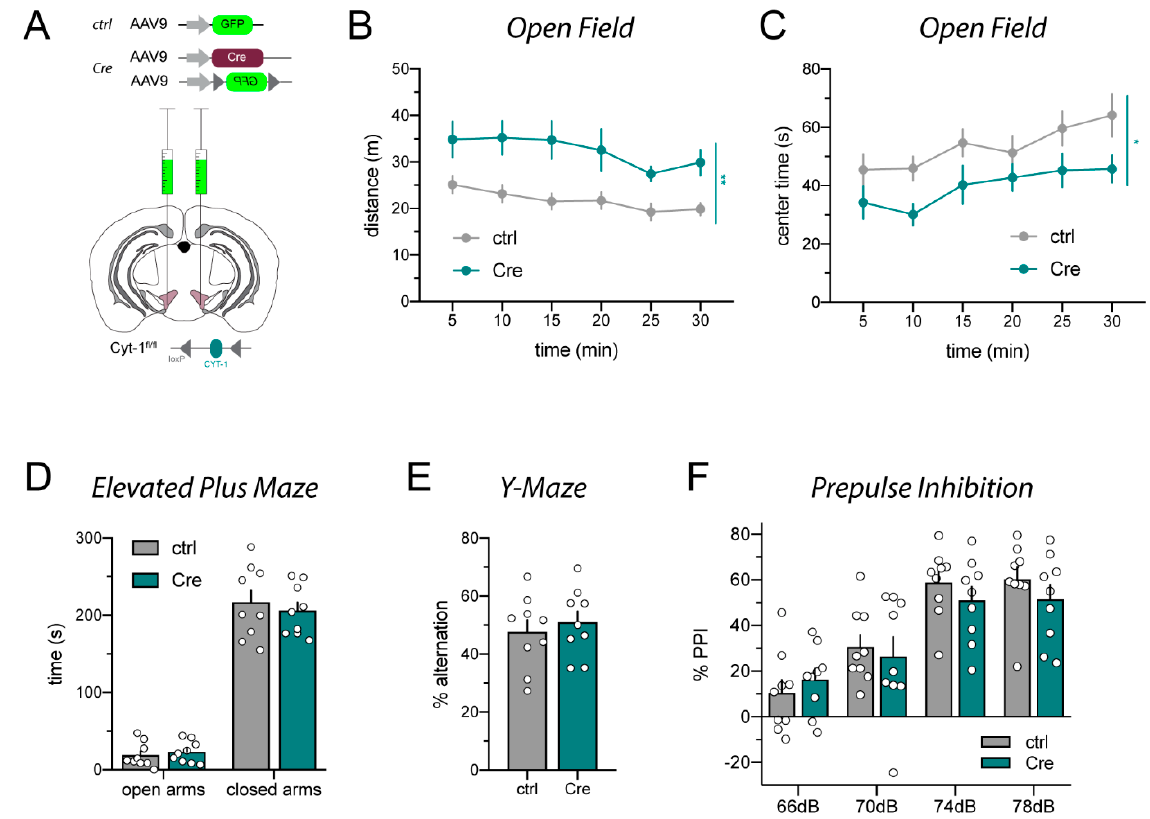
Figure 2. AAV9_Cre injections into the VTA of ErbB4 Cyt-1 fl/fl mice cause hyperactivity relative to AAV9-injected ErbB4 Cyt-1 fl/fl controls expressing GFP. ( A ) Scheme visualizing bilateral injection of AAV9_Cre/AAV9_DIO-GFP (Cre) and control AAV9_GFP (both 10 13 GC/mL, for details see Figure S1) into the VTA of adult ErbB4 Cyt-1 fl/fl mice. ( B ) AAV9_Cre-injected mice become hyperactive compared to control-injected mice in the open field (ctrl n = 9, Cre n = 9; mixed-effects model, F(5,77) = 0.6211, p = 0.6841 and genotype: p = 0.0083 **) and spent less time in the center of the maze ( C ; ctrl n = 9, Cre n = 9; two-way ANOVA, F(5,80) = 0.4144, p = 0.8374 and genotype: p = 0.0327 *). ( D ) Anxiety measured in the elevated plus maze (ctrl n = 9, Cre n = 9; two-way ANOVA, F(1,16) = 0.3410, p = 0.5674 and genotype: p = 0.6416). ( E ) Spontaneous alternation in the Y-maze (ctrl n = 9, Cre n = 9; unpaired t -test, p = 0.5718). ( F ) Prepulse inhibition did not differ between groups (ctrl n = 9, Cre n = 9; two-way ANOVA, F(3,48) = 1.431, genotype: p = 0.6086).